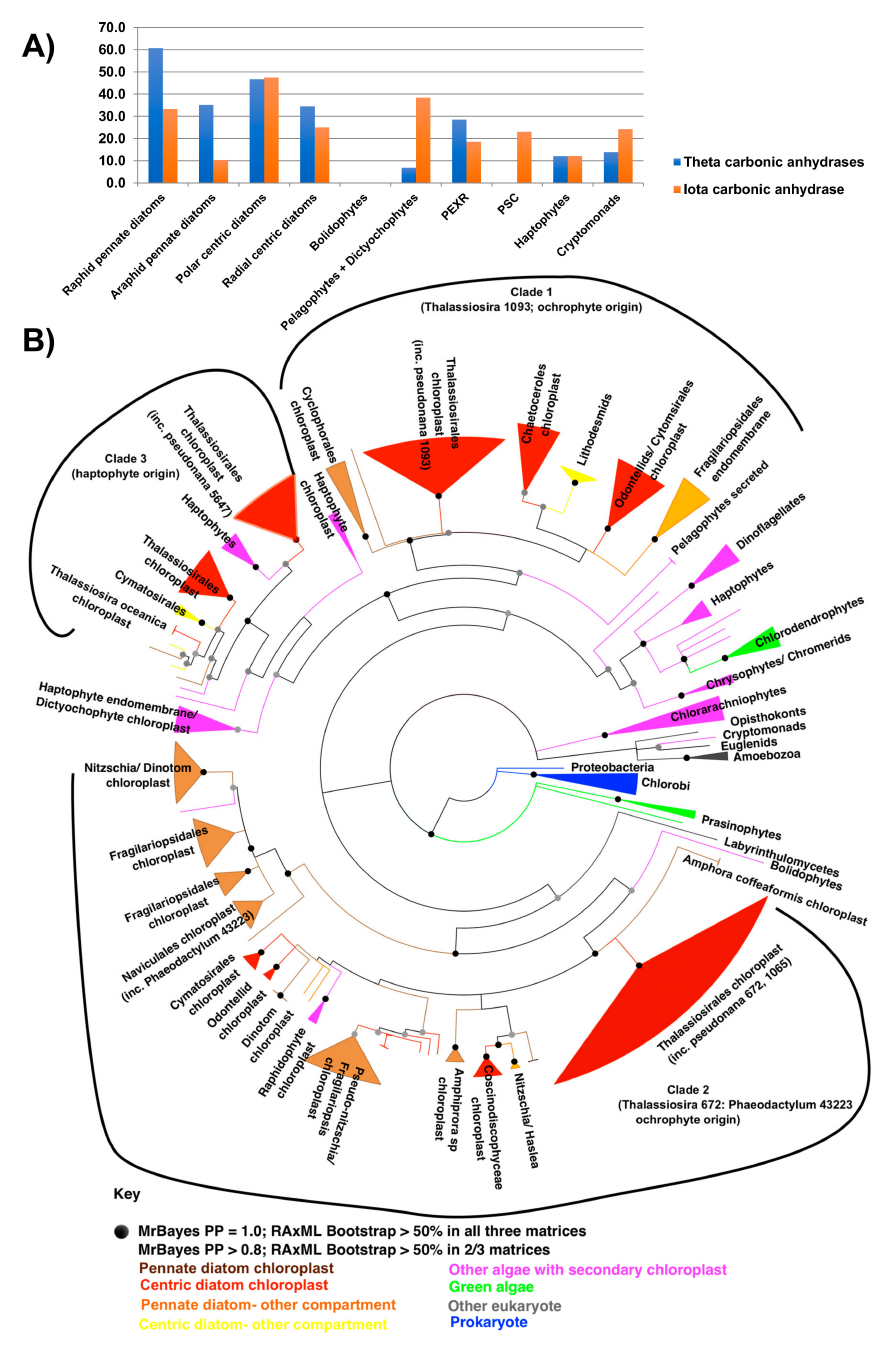
Figure 5. Evolution of chloroplast-targeted diatom carbonic anhydrases. Panel ( A ) shows the